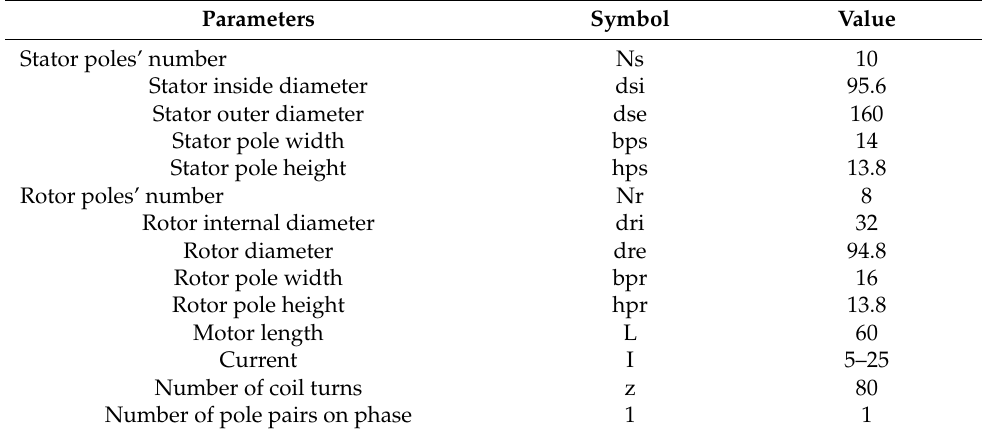
Table 6. Parameters used for model procurement of a 10/8 motor.